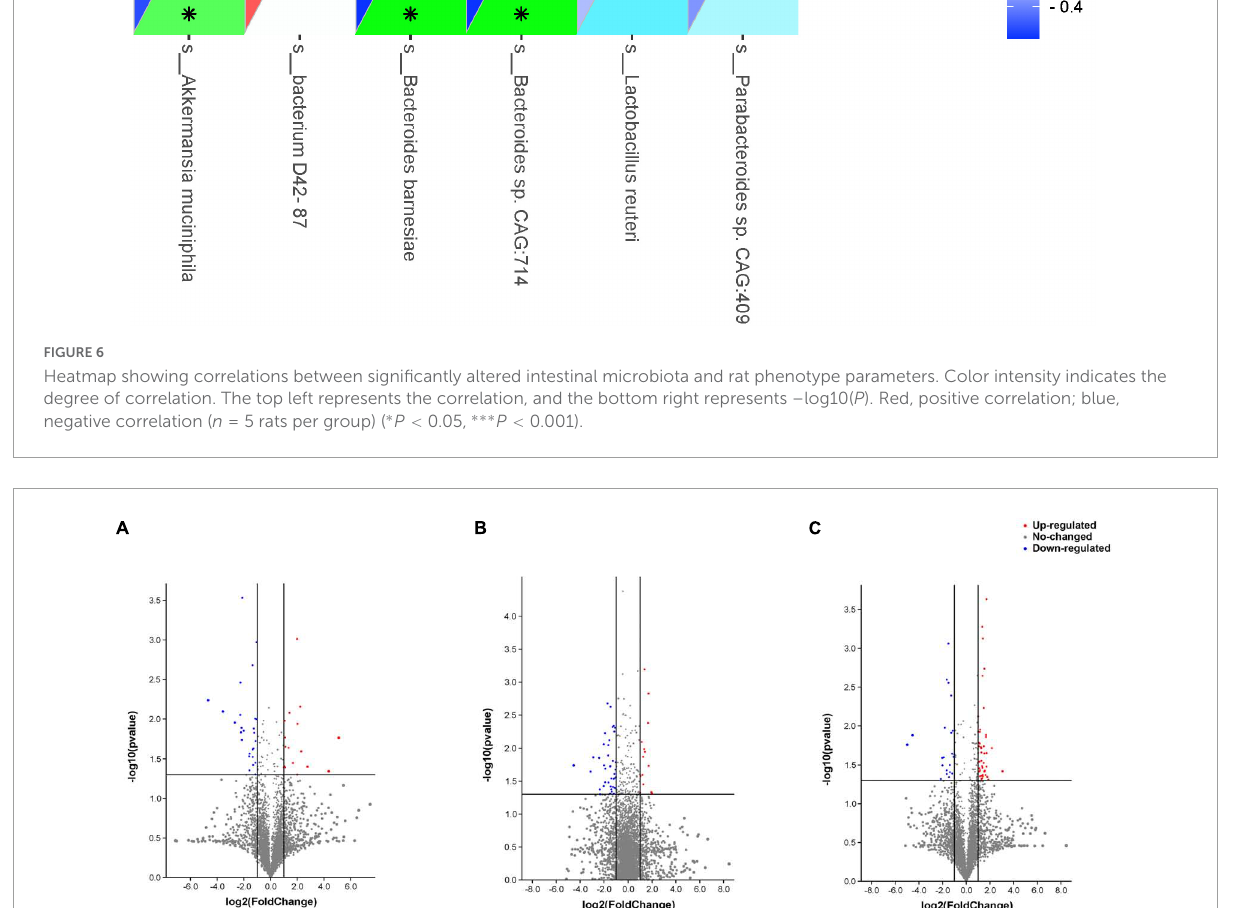
synthesizer of vitamin K. what’s more, it can maintain host intestinal homeostasis by regulating the level of short-chain fatty acids (SCFAs) (Nagpal et al., 2018), and it may also reduce the